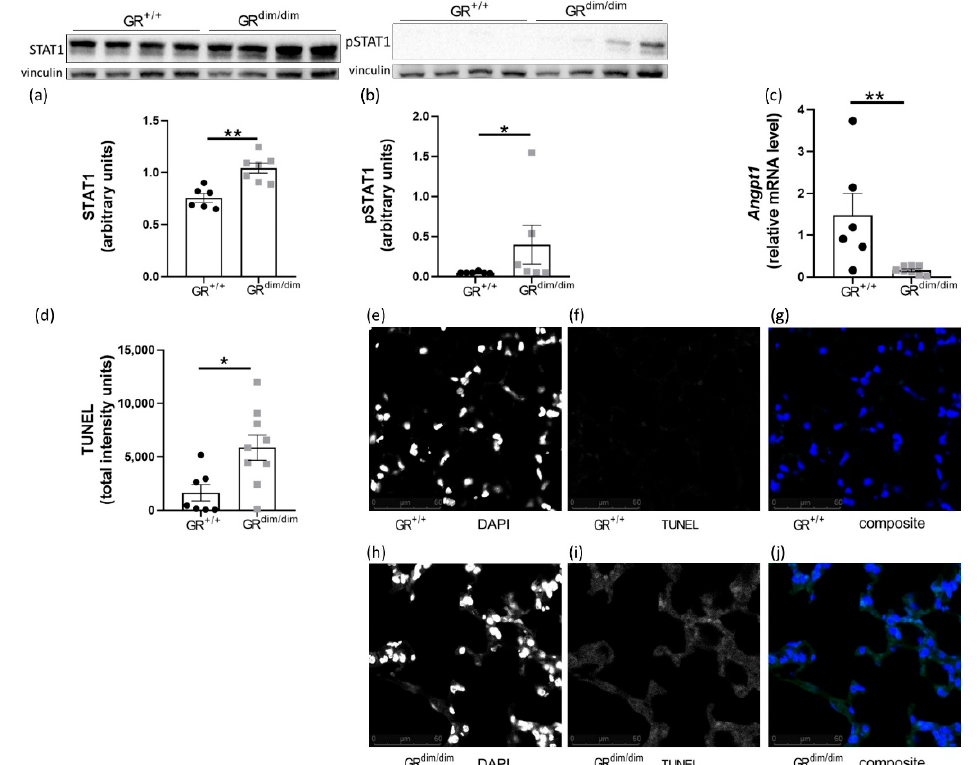
Figure 3. Increased apoptotic signaling in lungs from GR dim/dim mice after HS. In lung tissue samples from GR dim/dim mice, significantly ( a ) higher protein level of STAT1, ( b ) higher protein level of pSTAT1 and ( c ) reduced Angpt1 expression was found compared to lung tissue of GR +/+ mice after HS. ( d ) Lung sections of GR dim/dim mice showed stronger TUNEL staining indicating increased apoptosis compared to lung sections of GR +/+ after HS. Representative pictures at 40 × magnification are shown for GR +/+ lung sections stained with ( e ) DAPI for detection of nuclei and ( f ) TUNEL (flourescein-dUTP) for detection of apoptosis and ( g ) both (composite). Representative pictures at 40× magnification are shown for GR dim/dim lung sections stained with ( h ) DAPI, ( i ) TUNEL and ( j ) both. Only nuclear TUNEL signal was used for quantification. Data are shown as mean with SEM. Significance was analyzed with unpaired Mann-Whitney and indicated according to * p < 0.05, ** p < 0.01.